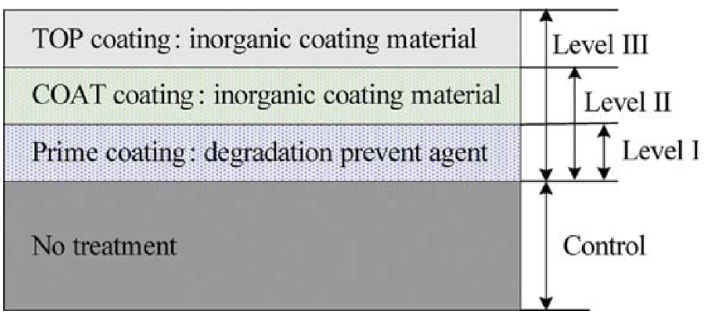
Figure 5. Coating levels obtained with spray coating method [30].